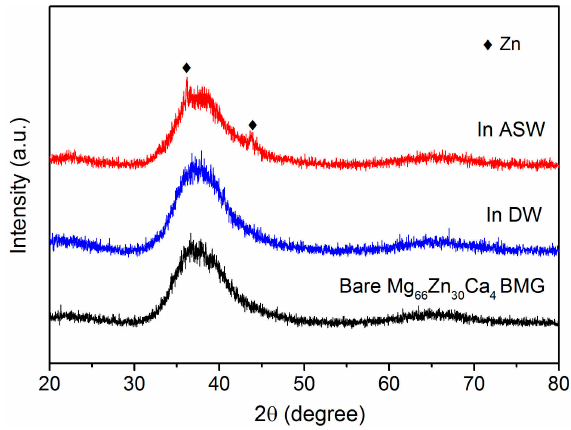
Figure 2. XRD (X-ray diffractometry) spectra of MZC ribbons after different treatments (BMG: Bulk metallic glass) .